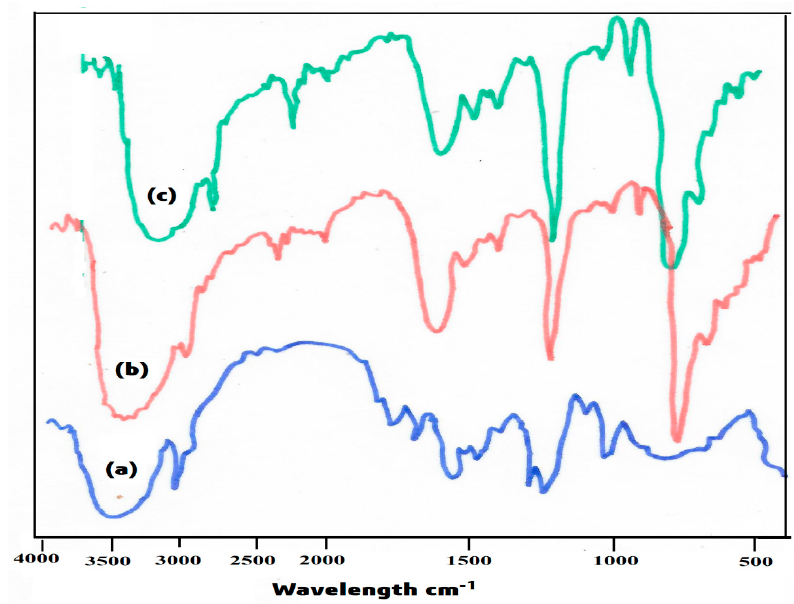
Figure 2. FTIR Spectra of ( a ) Pure PVA ( b ) St-g-PMA and ( c ) PVA-g- St-g-PMA.